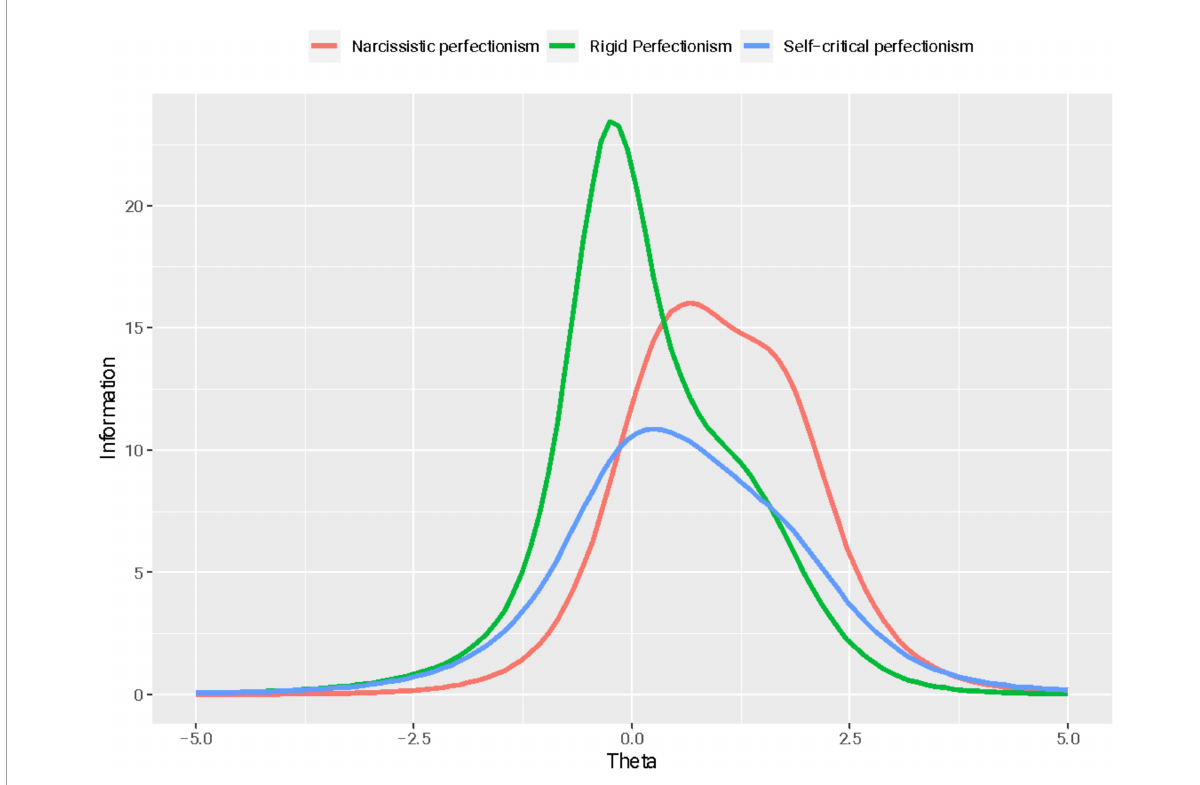
TABLE 2 The Big Three Perfectionism Scale–Short Form: Indexes of reliability for each dimension ( n = 401). BTPS-SF dimension α ω H EAP ρ